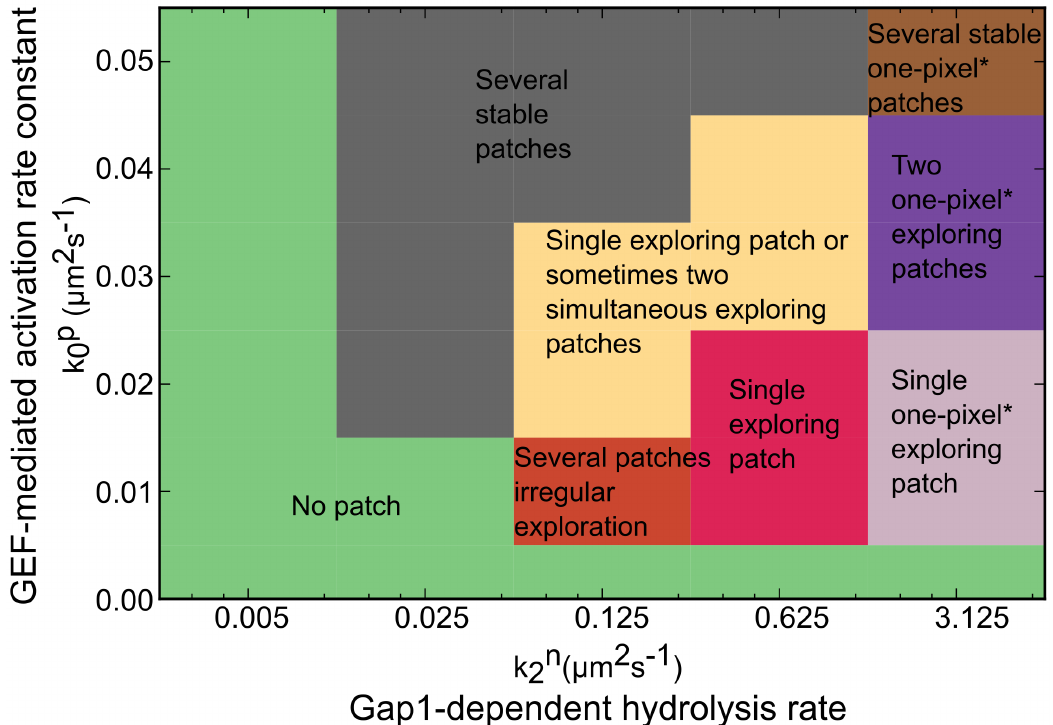
Fig 5. Regions of dynamical behavior. Behavior observed in simulations for different values of k p , the GEF-mediated activation 0 rate constant of Ras1-GTP, and k n , the Gap1-dependent hydrolysis rate constant of Ras1-GTP. Other free parameters were kept as 2 shown in Table 1. The yellow region represents simulations that mostly show a single patch oscillating however sometimes there are two patches that form simultaneously and then disappear at the same time or one after the other. One pixel (cid:3) is one voronoi cell of the simulated surface.